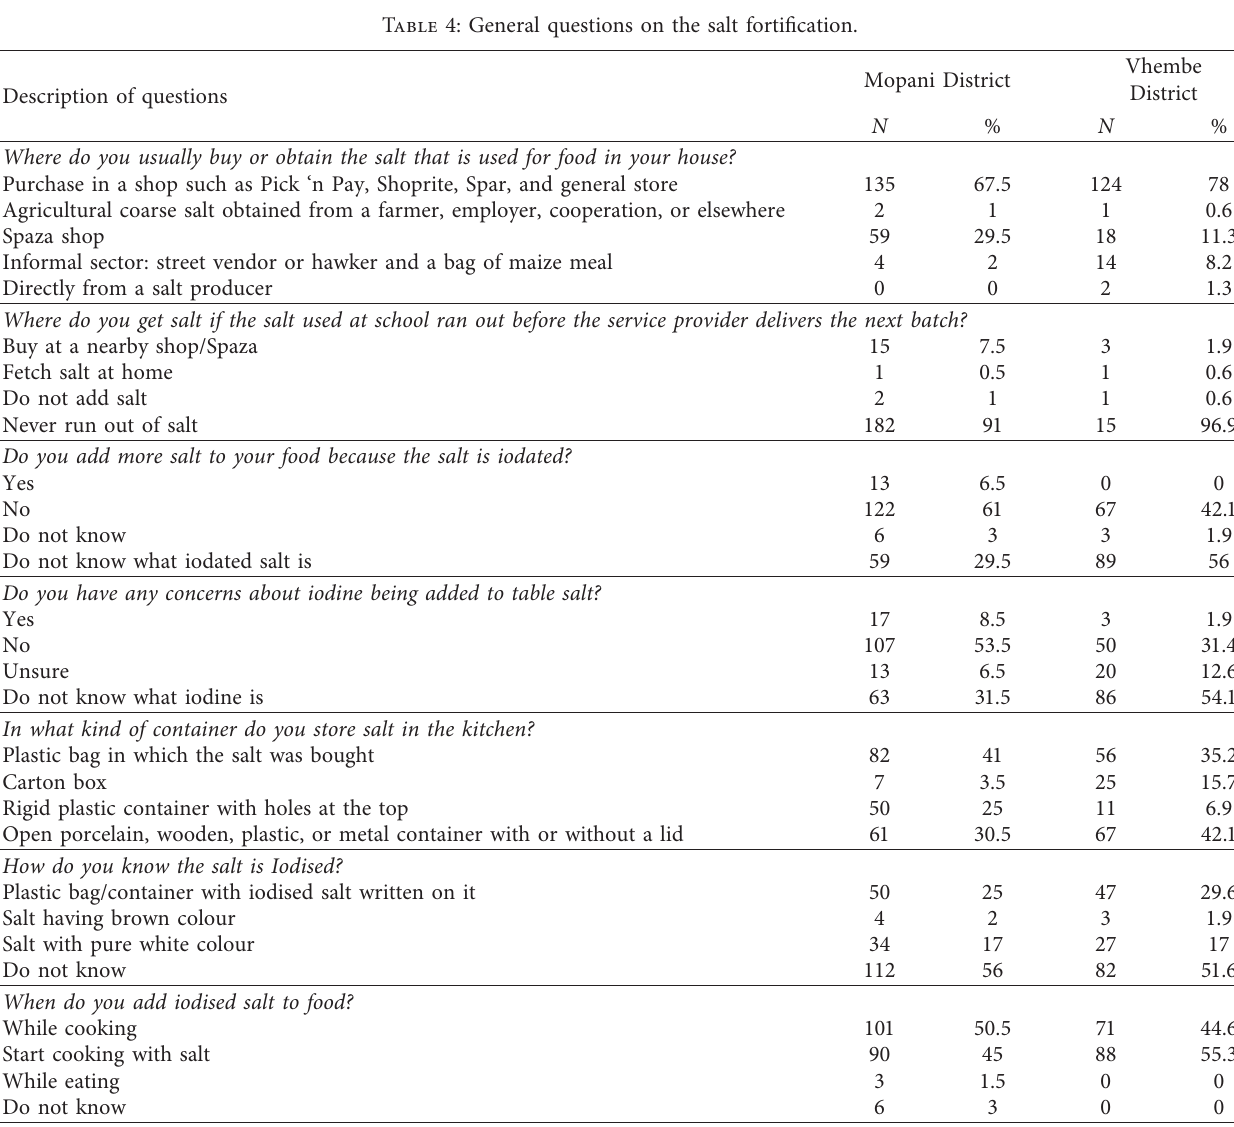
Table 4: General questions on the salt